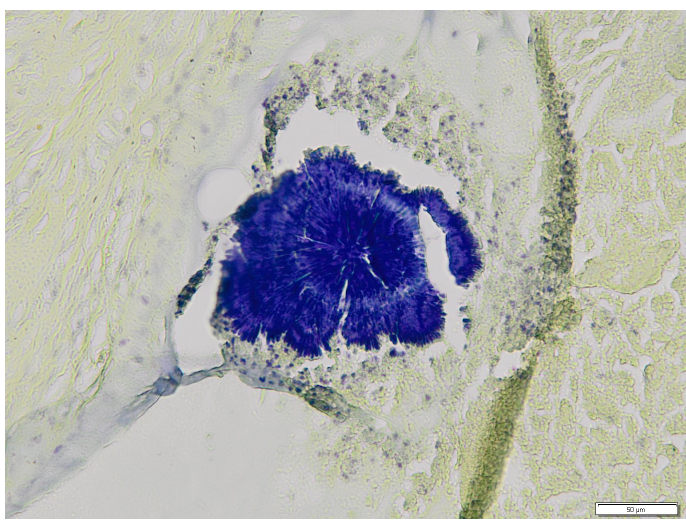
Fig. 3. Strongly Gram-positive radiating granules reveal peripheral club- bing (arrows)